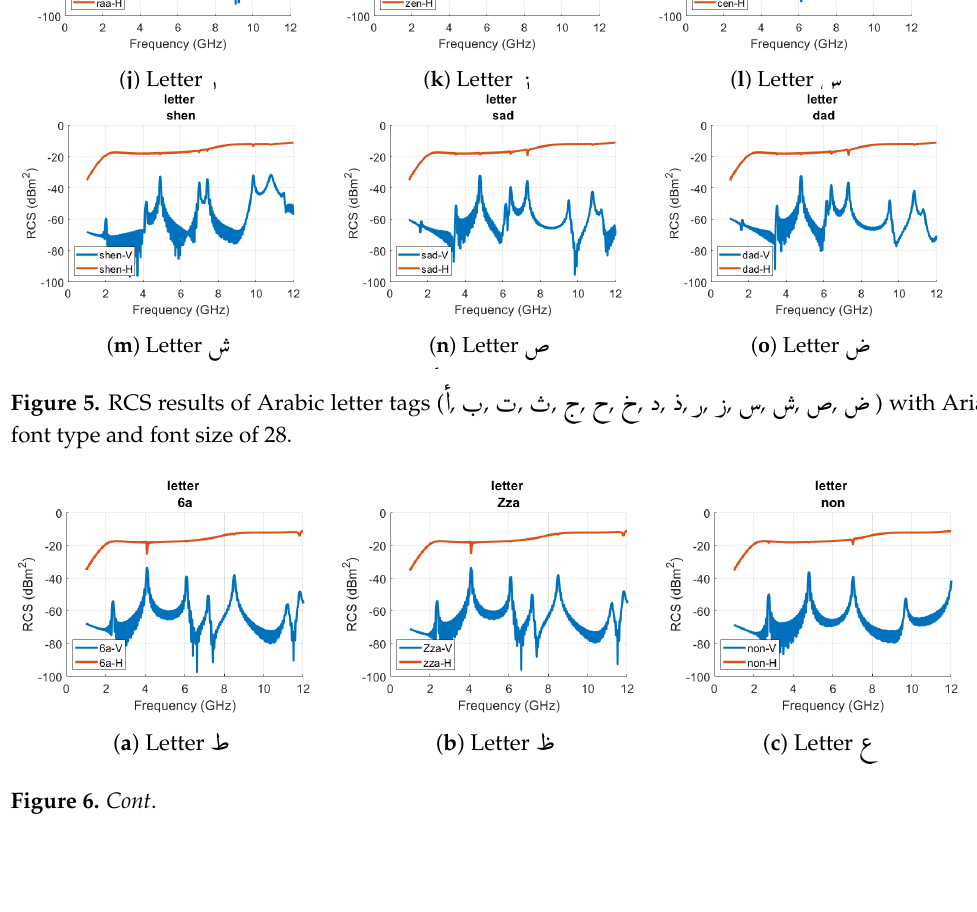
Figure 6. Cont . Figure 6. Cont .